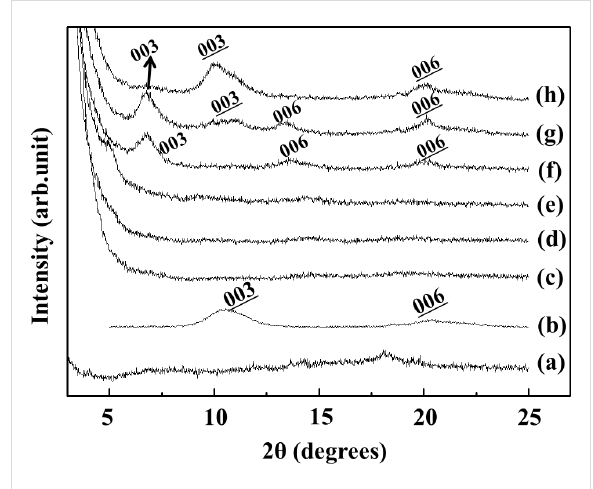
Figure 1: X-ray diffraction (XRD) patterns of products prepared by ion exchange between MgAl-LDH and GMP under controlled GMP/LDH molar ratios at 80 °C for 1 day. (a) GMP only, (b) MgAl-NO 3 -LDH, (c) 1:0.25, (d) 1:0.5, (e) 1:1, (f) 1:2, (g) 1:4, (h) 1:10 (GMP/LDH). Underlined Miller indexes are (00 l ) of NO 3 − interlayer anion (MgAl-NO 3 -LDH). Miller indexes without underline are (00 l ) of GMP intercalated